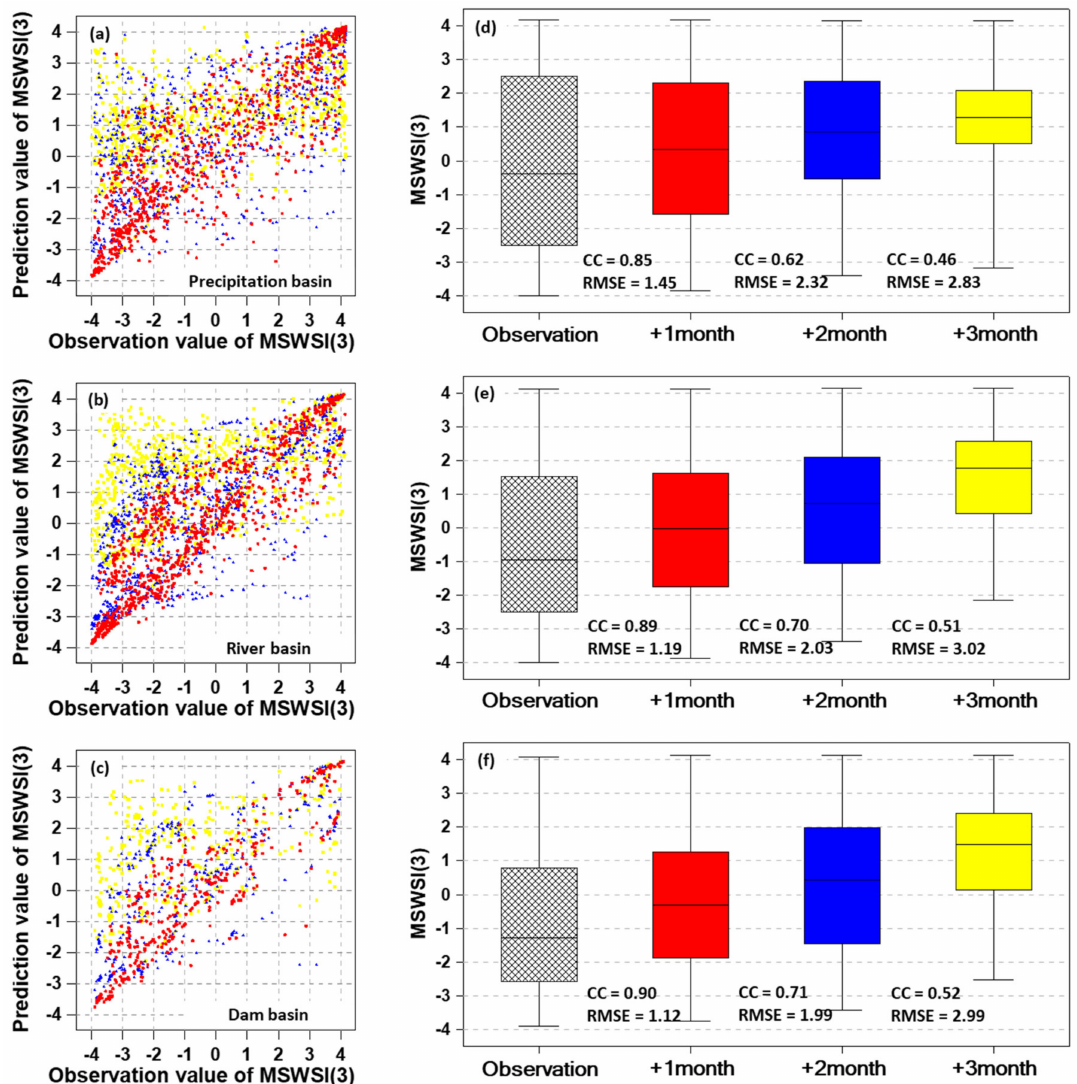
Figure 8. Correlation analysis ( a , b , c) of MSWSI(3) and box whisker plots of MSWSI(3) ( d , e , f ) for 1 − , 2 − and 3 − month lead times during the 2015 − 2016 drought events. The red − , blue − and yellow colors indicates the MSWSI(3) for 1 − , 2 − and 3 − month lead